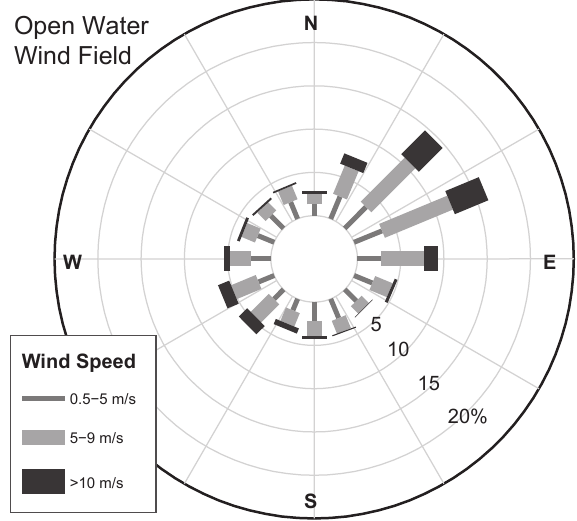
Figure 3. Wind field at Drew Point during the open water season. The wind field is dominated by wind from the ENE, but shows a smaller secondary maximum from the WSW (data from Urban and Clow,